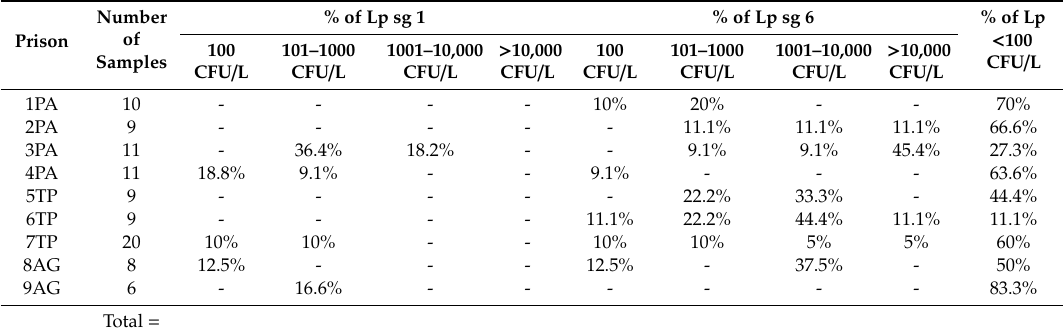
Table 1. Level of Legionella pneumophila (Lp) serogroup (sg) 1 and sg 6 in samples analyzed before the